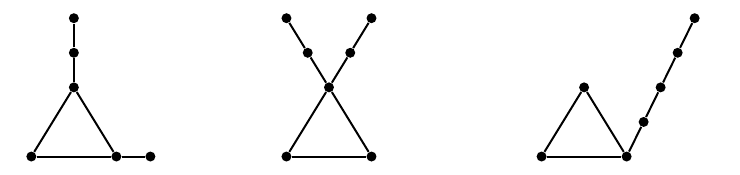
Fig. 4: Three underlying graphs of signed graphs Γ with θ ( Γ ) = 4